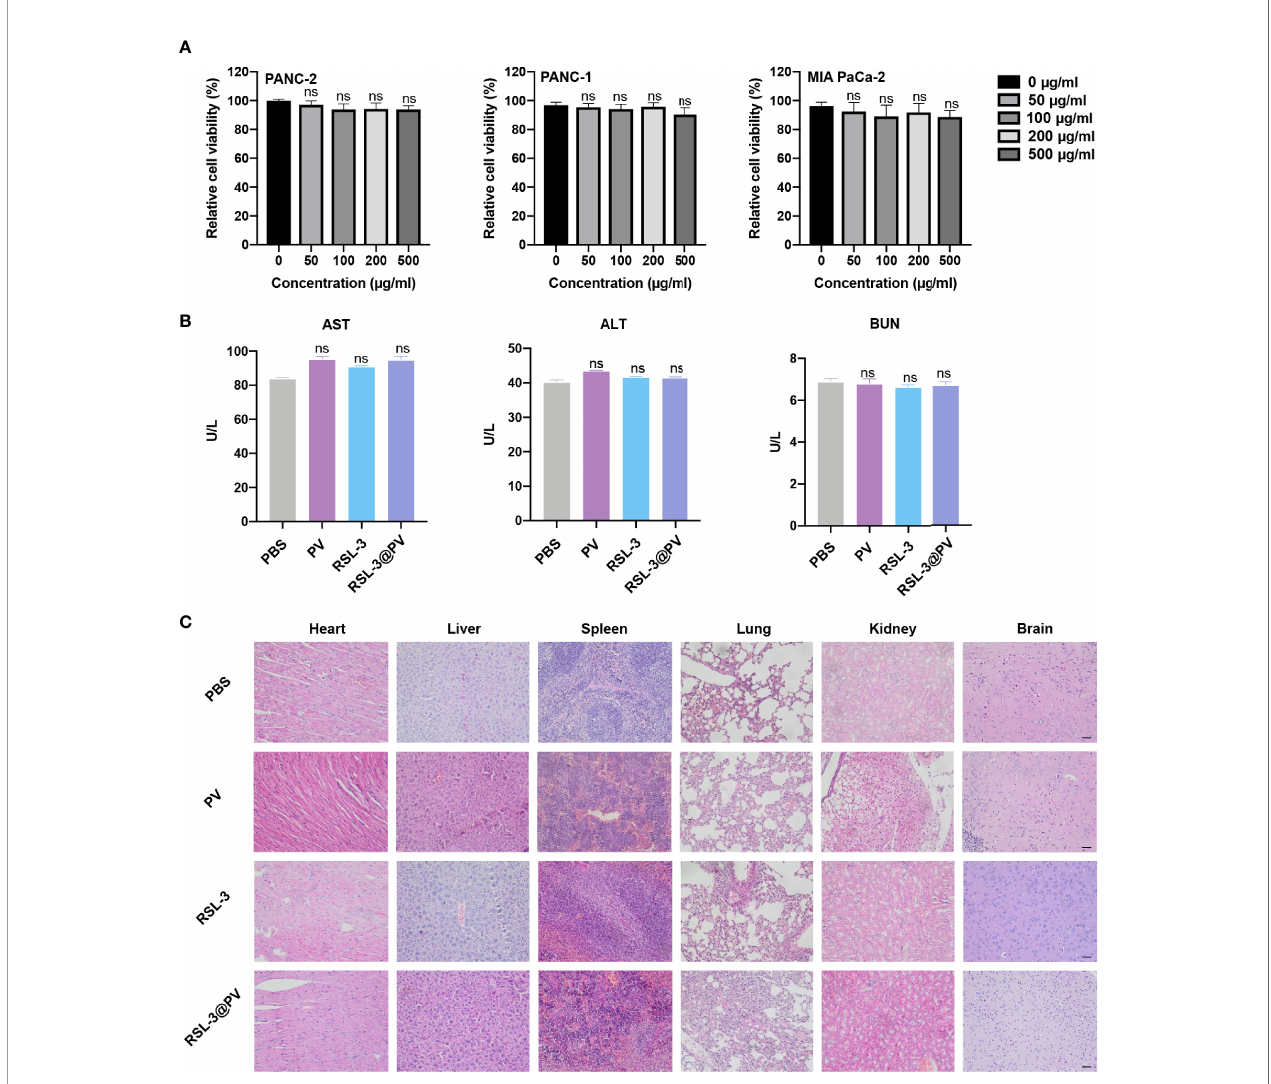
FIGURE 5 | In vitro and in vivo safety evaluation of RSL-3@PVs. (A) Relative cell viability of PANC-2, PANC-1, MIA PaCa-2 at different concentrations. (B) Liver and kidney function (AST, ALT and BUN) in serum of healthy ICR mice after treatment with the indicated formulations. (C) Representative images of major organs from mice after treatment with the indicated formulations. Scale bars, 100 m m. Error bars represent the mean ± s.d. One-way ANOVA was used for multiple comparisons, ns P >